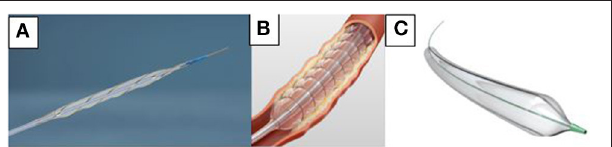
FIGURE 1 | Specialized PTA Balloons. (A) Angiosculpt (BD Bard, New Jersey, USA). (B) Chocolate PTA Balloon (Medtronic, Santa Rosa, CA, USA). (C) Ultrascope (BD Bard, New Jersey,